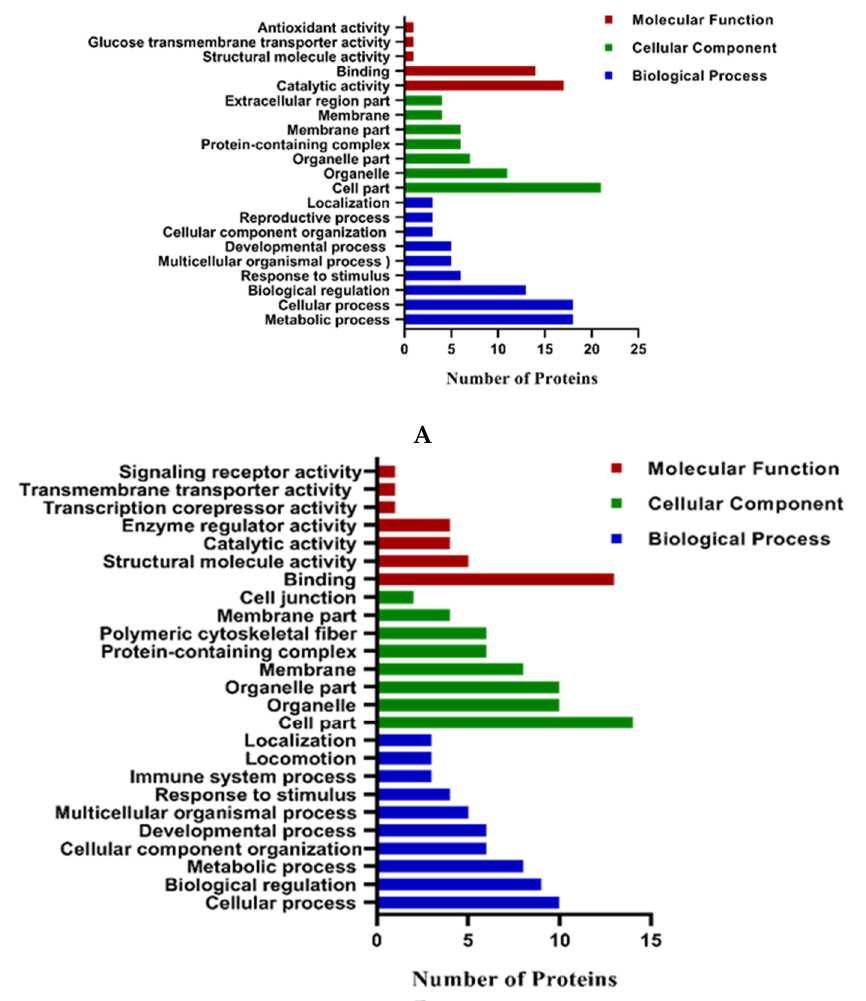
Figure 7. Gene ontology analysis of upregulated ( A ) and downregulated ( B ) proteins in 5% O2 embryos. Proteins were classified according to cellular localization, biological processes and molecular functions. The results are displayed as a number of proteins classified to each category.